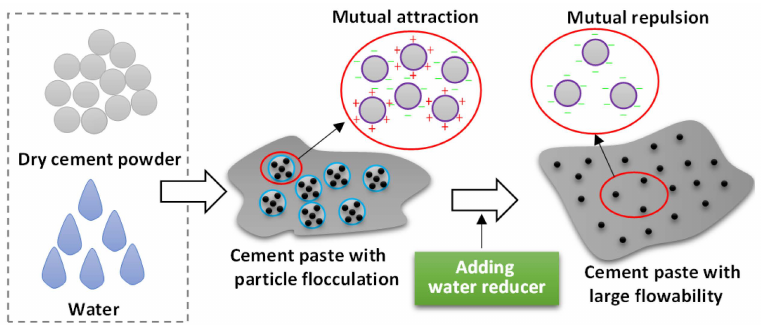
Figure 13. Mechanism of water reducer affecting cement